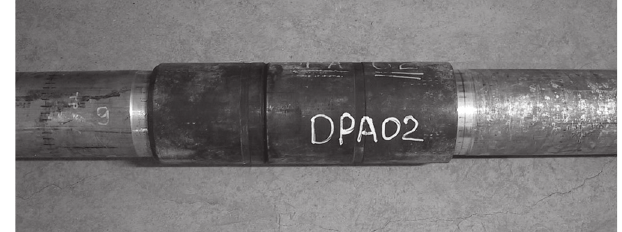
Figure 3. Tool joint region of DPA02 specimen.